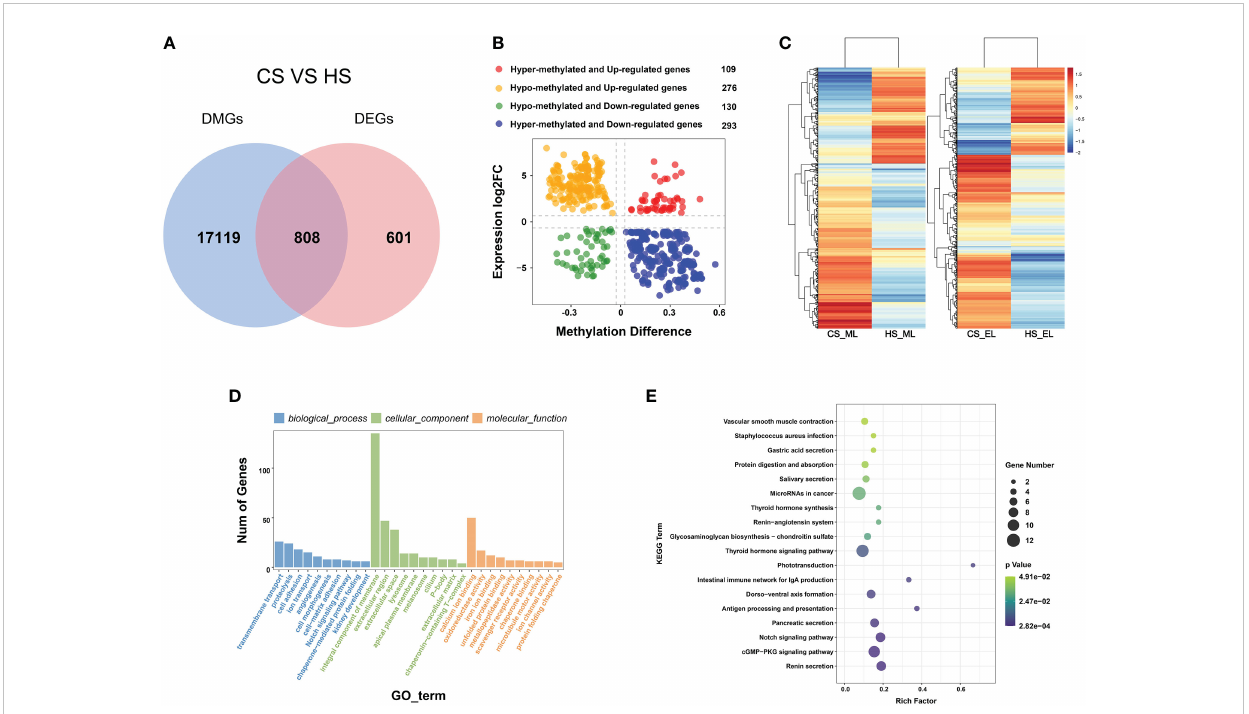
FIGURE 5 (A) Venn plot of DMGs and DEGs between CS and HS. (B) Scatter plot of the correlation between expression levels of DEGs and methylation difference of DMGs in 808 shared genes. (C) Heatmap of methylation levels (ML) and expression levels (EL) of 808 shared genes in CS and HS. (D) Bar chart of GO enrichment of 569 negatively correlated genes between DEGs and DMGs. (E) Scatter plot of KEGG enrichment of 569 negatively correlated genes between DEGs and